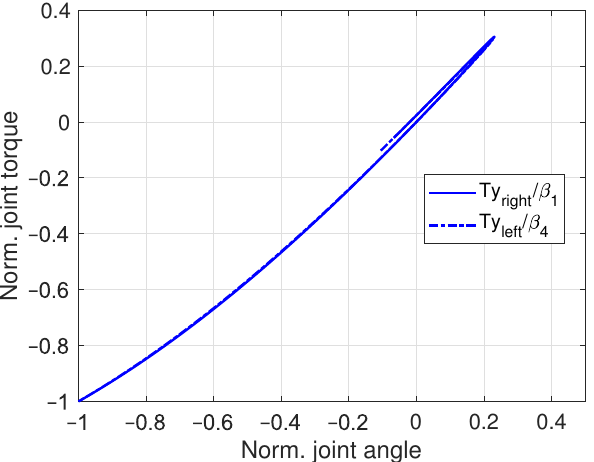
Figure 8. Normalized shoulder joint torques over normalized joint